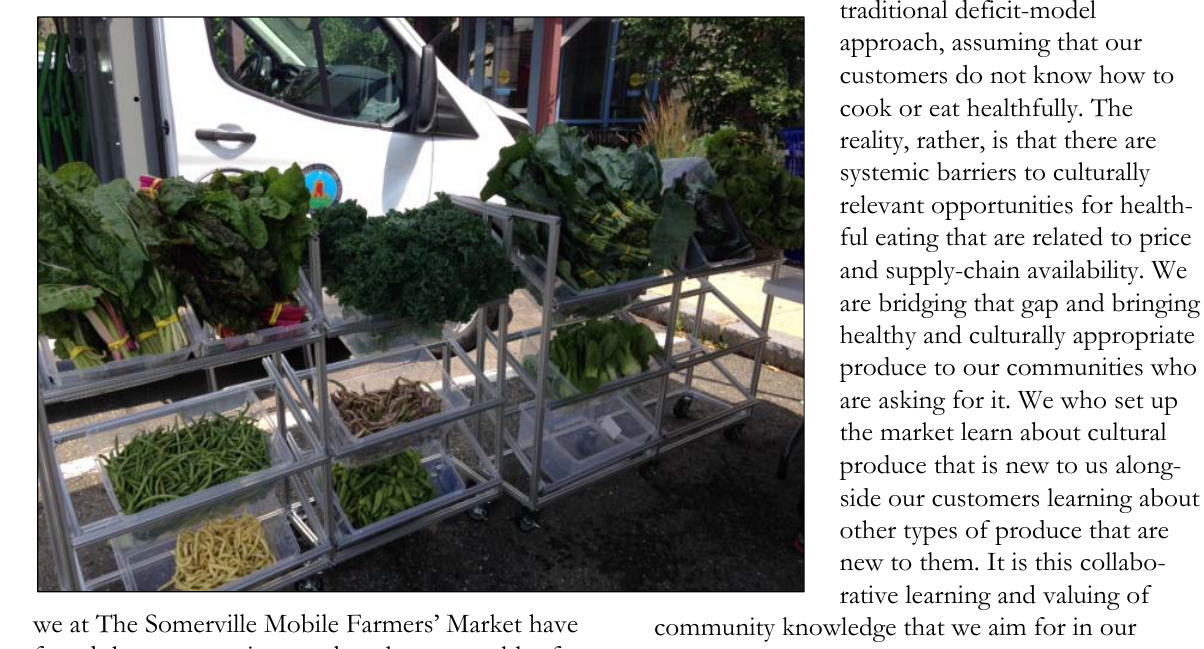
Figure 2. Rolling racks let us set up in any space and move